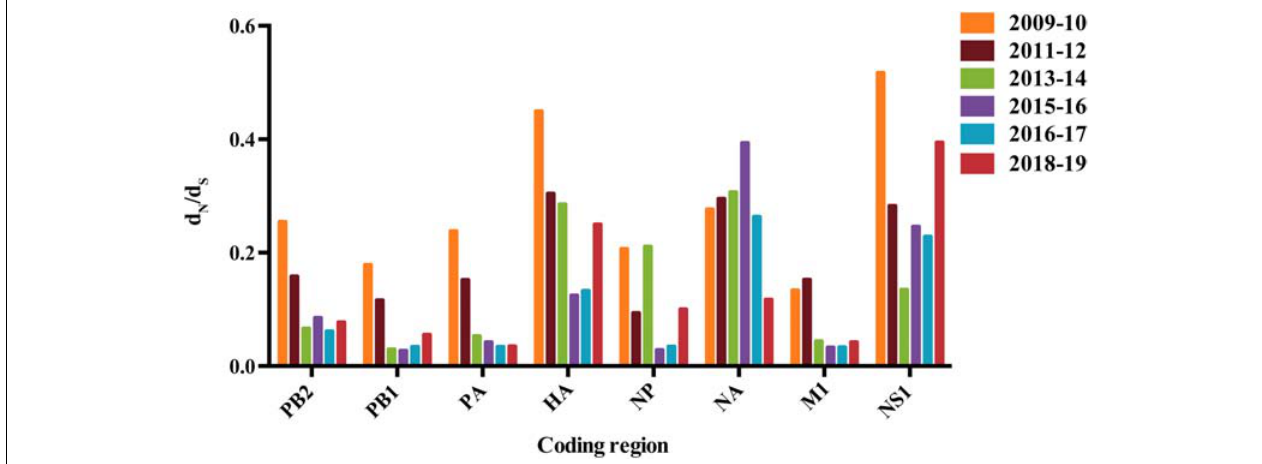
FIGURE 1 | The dN/dS values for major genes of A/H1N1pdm virus. Colored bars correspond to different years. This dN/dS value represents an average over all sites and